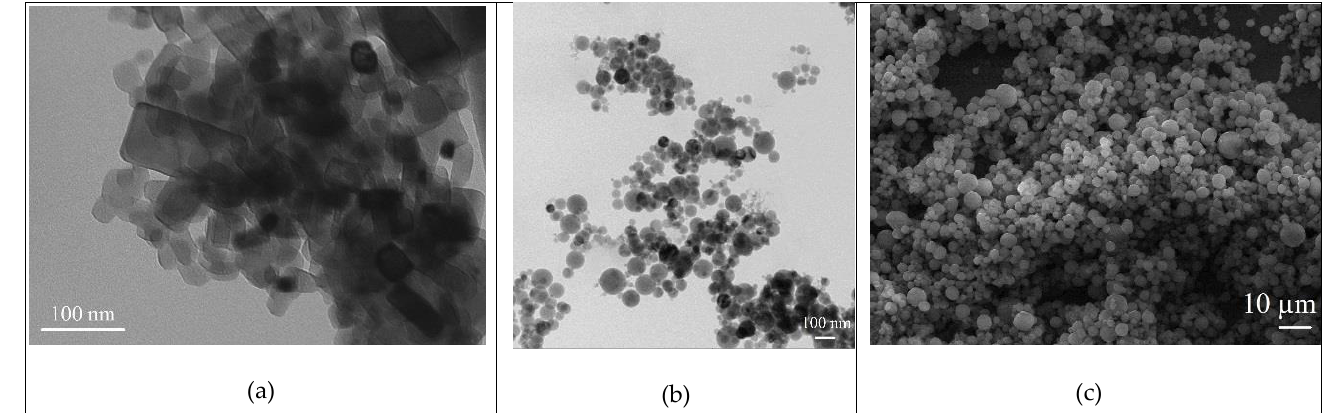
Figure 1. Transmission electron microscopy (TEM) images of initial powders: ScF 3 ( a ); Al 2 O 3 ( b ); Al ( c ).